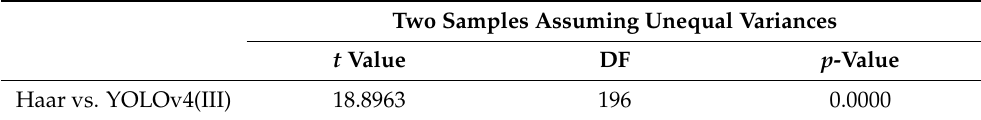
Table 9. Independent sample test using 191